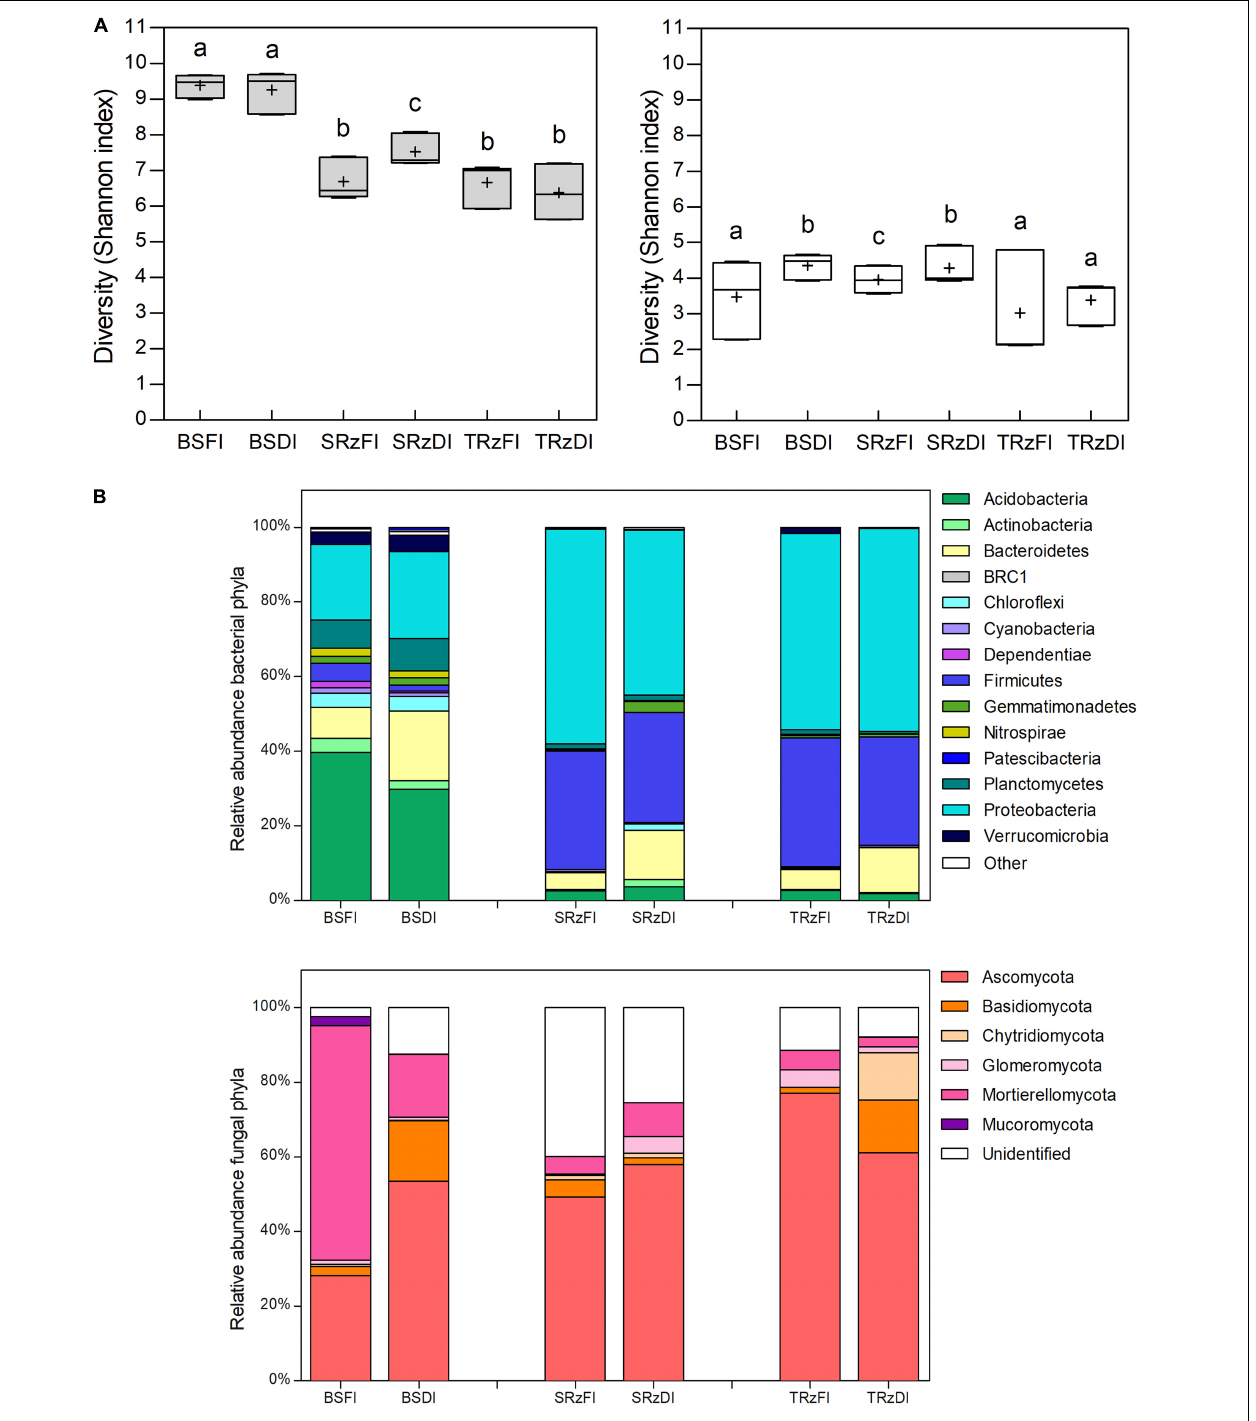
FIGURE 2 | Diversity and taxonomic composition of soil microbial communities. (A) Ten sub samplings of random sequences without replacement of each sample were used to compare the diversity Shannon index between the soil type/water irrigation treatments ( n = 30; gray bars bacteria; white bars fungi). Horizontal bars within boxes represent the median; crosses represent the media. The tops and bottoms of the boxes represent 75th and 25th quartiles, respectively. Bars with different letters indicate statistically significant differences (Kruskal–Wallis analysis of variance p < 0.05 and Dunn’s post hoc test). (B) Average phylum taxonomic composition of bacterial (upper panel) and fungal (lower panel) communities from different water irrigated soils ( n = 3). Different colors represent distinct phyla. Other represent phyla with relative abundances < 1% in all samples. FI, full irrigation; DI, deficit irrigation. BS, bulk soil; SRz, susceptible cultivar rhizosphere; TRz, tolerant cultivar